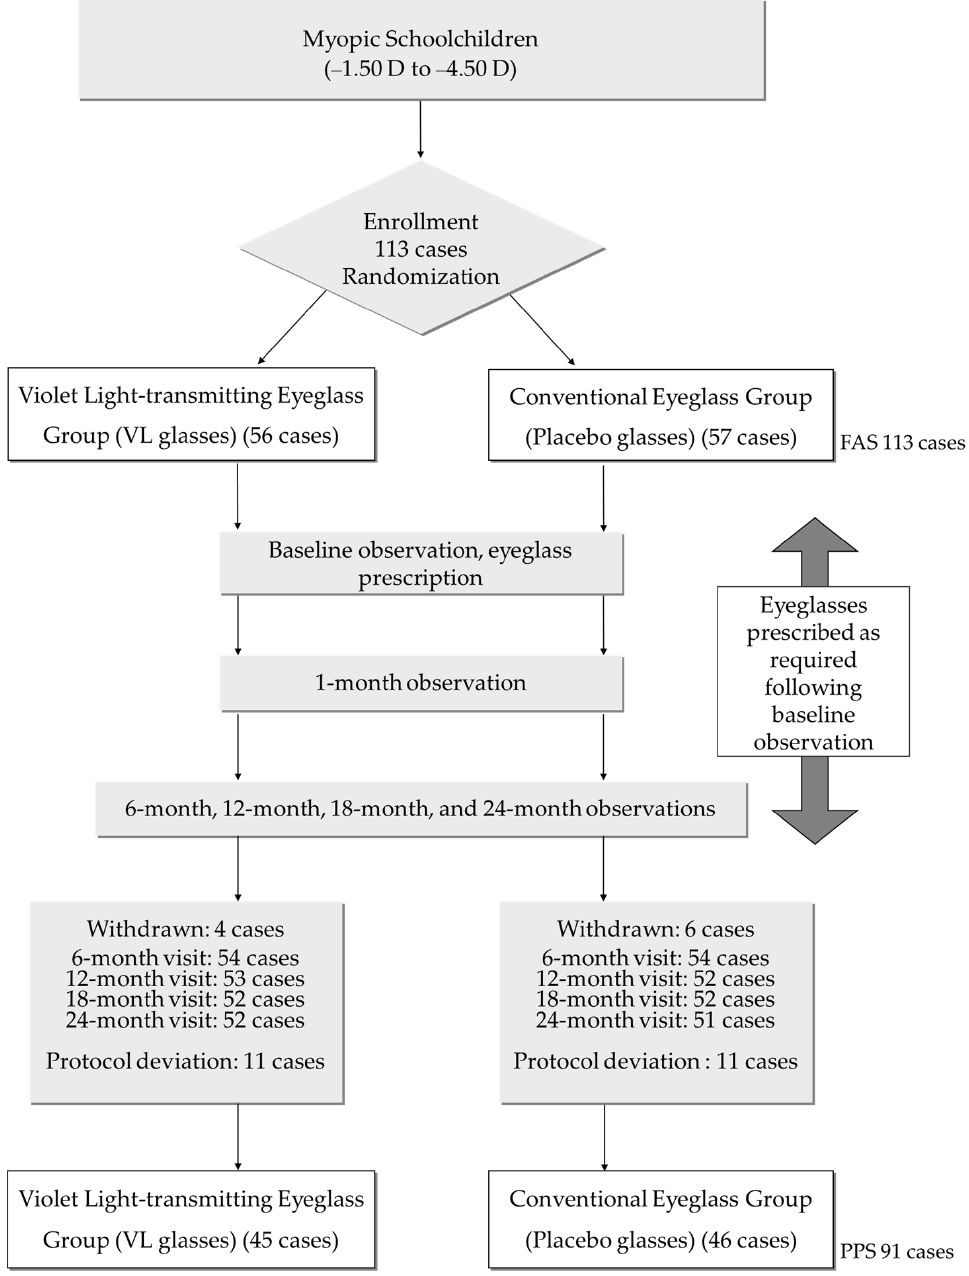
Figure 1. Flowchart of the double-blind randomized clinical trial time points and number of participants. Details of the reasons for withdrawal and protocol deviation are described in Table S1. FAS: full analysis set; PPS: per protocol set.